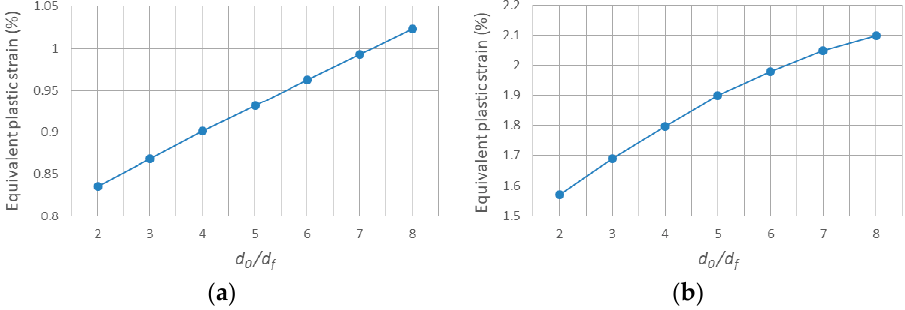
Figure 22. Equivalent plastic strain fields in cross section XOZ with varying ratios between center distance of adjacent SiC fibers d 0 and fiber diameter d f : ( a ) d 0 /d f = 8, ( b ) d 0 /d f = 6, ( c ) d 0 /d f = 4, ( d ) d 0 /d f = 2.